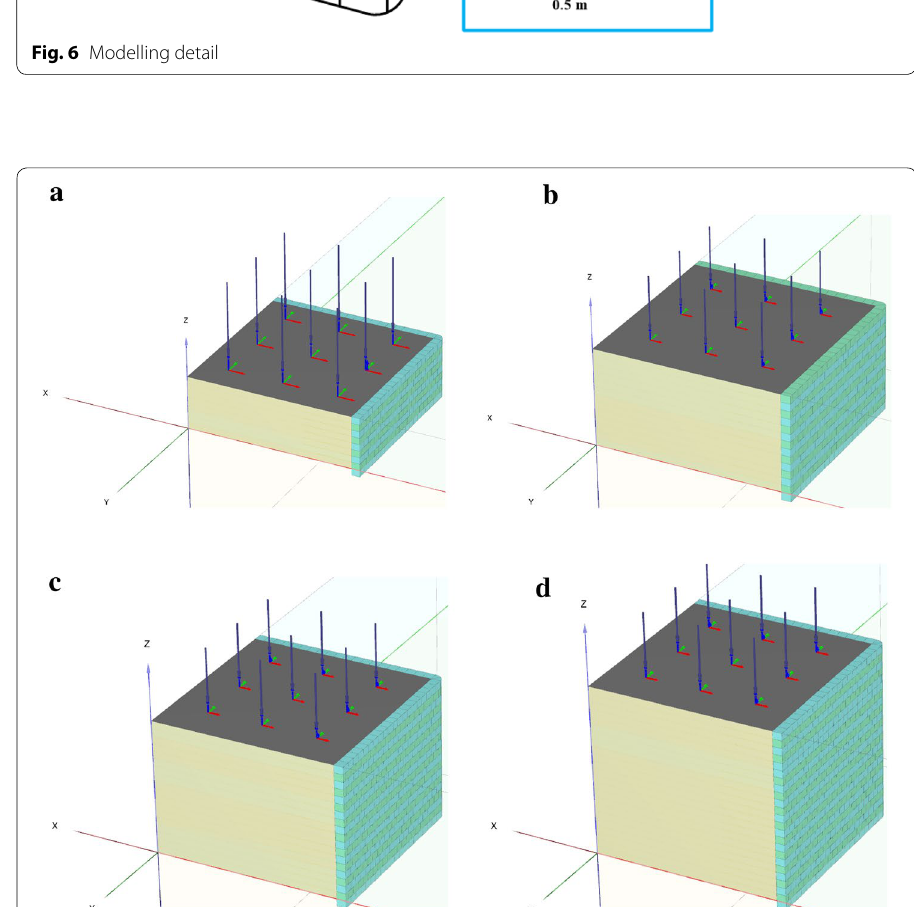
Fig. 7 Modelling according to four cases: a CASE 1; b CASE 2; c CASE 3; d CASE